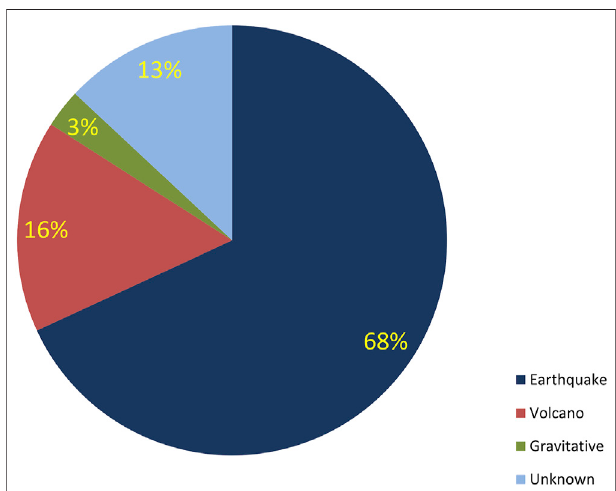
FIGURE 4 | Distribution of the tsunamis in ITED by generating cause, with the number of tsunamis indicated for each cause.